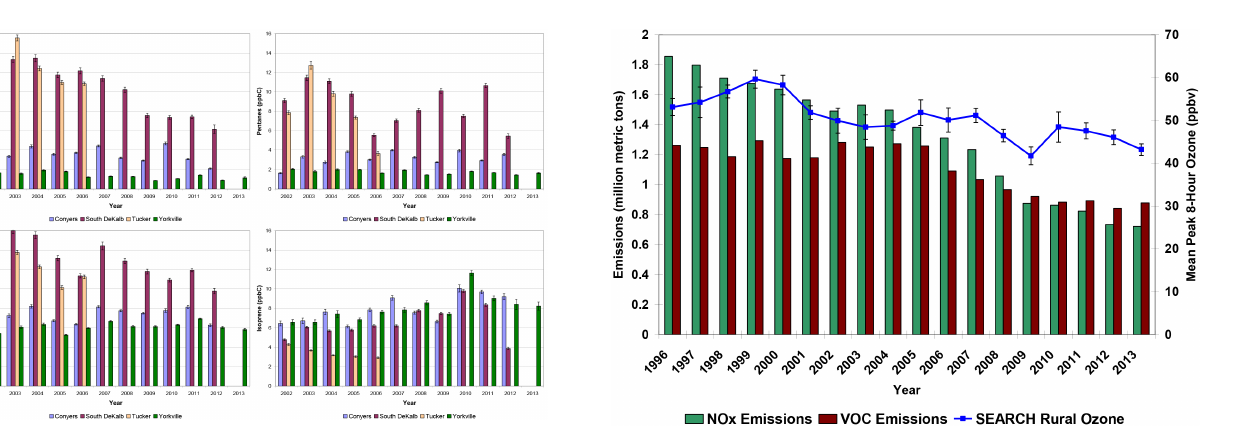
Figure 9. Mean peak 8h O 3 at rural SEARCH sites during the months of March through October compared with anthropogenic NO x and VOC emissions in Alabama, Georgia, Mississippi, and northwest Florida. The 2012–2013 NO x emissions were estimated beginning in 2011 using the 2011 and 2012–2013 CEMS data for EGU